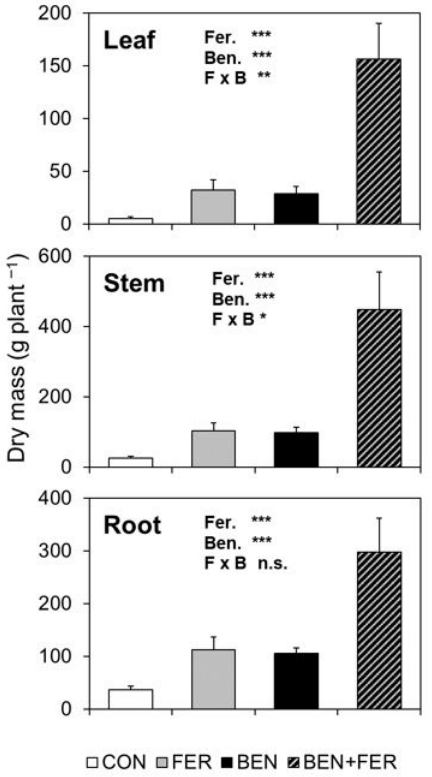
Figure 5. Dry mass of each organ and total dry mass for teak seedlings at the end of the experiment (November 2015) grown in the four treatments (mean ± SE, n = 12). Asterisks indicate significant differences by two-factor ANOVA. * = p < 0.05, ** = p < 0.01 and *** = p <